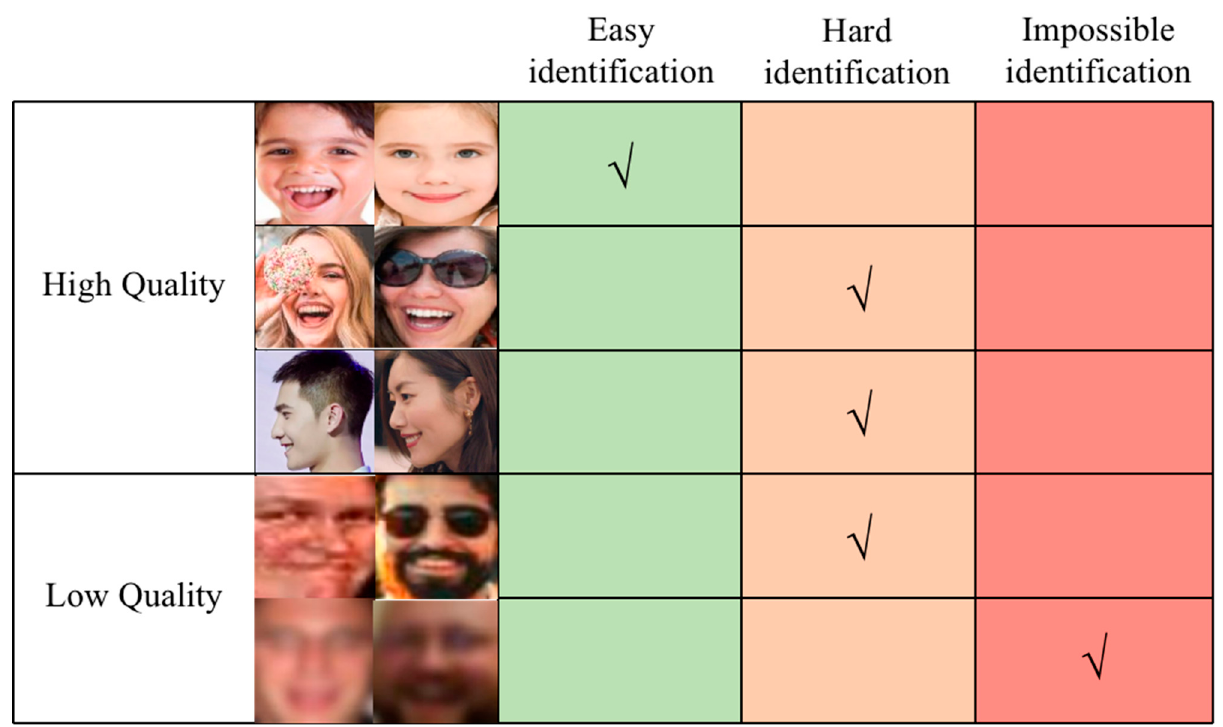
Figure 6. Different levels of image recognition with varying image qualities.